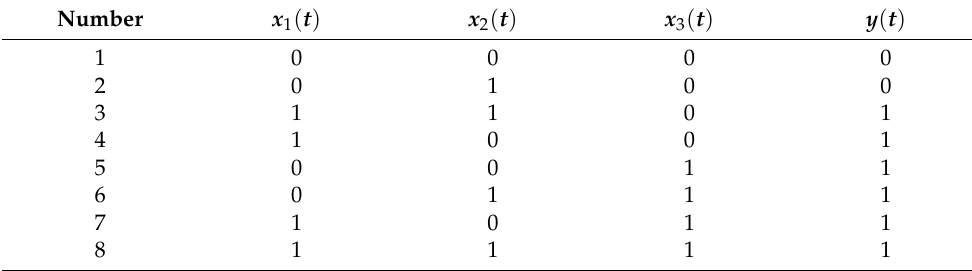
Table 5. The quantitative operation rules of the FB